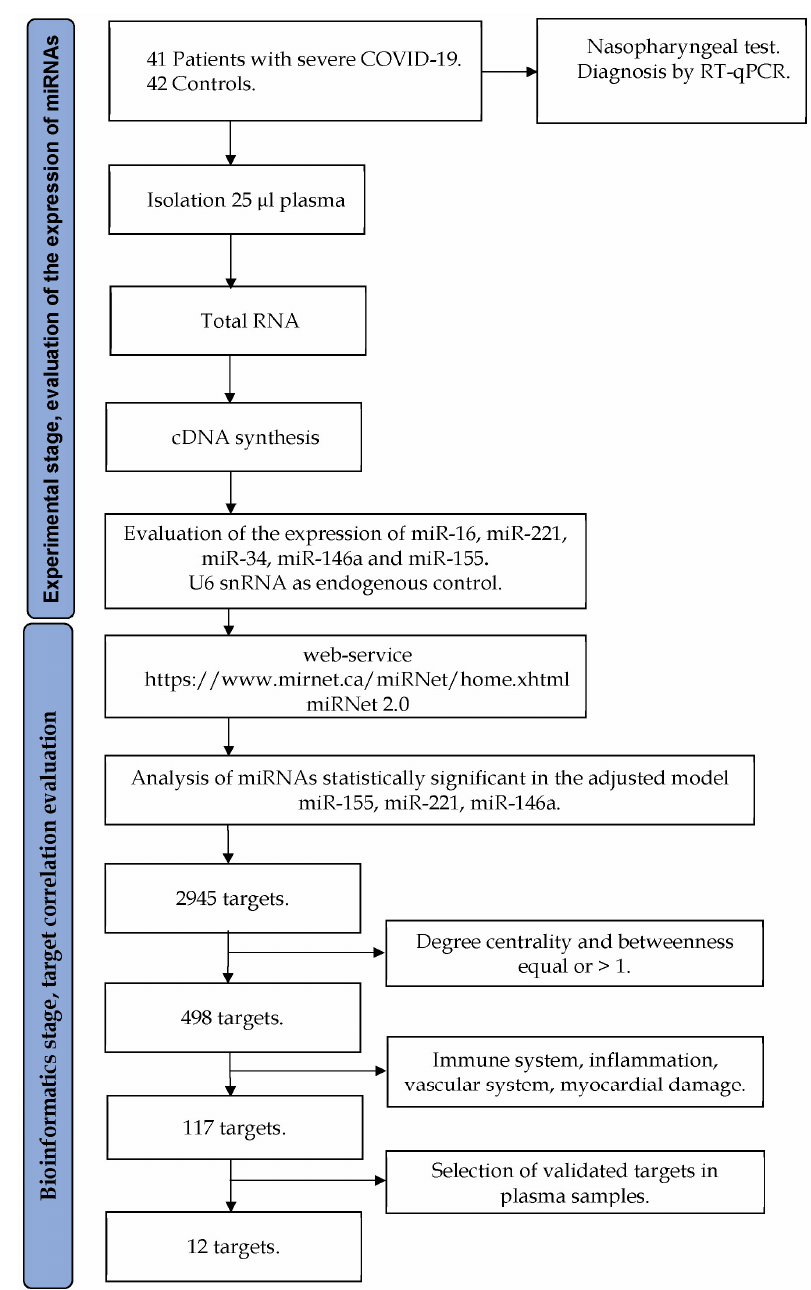
Figure 1. Flowchart diagram of the experimental design and data analysis.